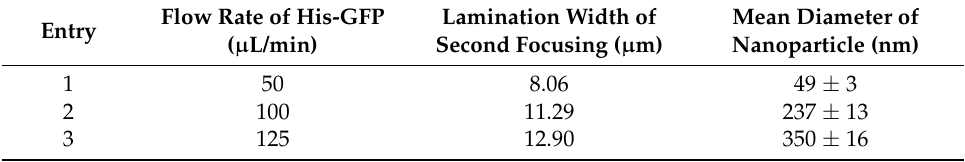
(c) Figure 7. Evaluation of the produced protein nanoparticles: ( a ) TEM image; ( b ) scanning electron microscope (SEM) image; ( c ) confocal fluorescence image. 5. Conclusions This paper examines the fast and controllable preparation of the protein nanoparticles in the flow-focusing synthesis channel. The Ni-NTA-PS and His-GFP was self-assembled on the interfacial surface of the multi-laminated flow. Especially, the problem of aggregation and clogging of the self-assembled protein nanoparticles on the inner surface of the channel was improved by adding the retarding inlet channel. The width of the solution introduced from the retarding inlet channel could be controlled simply by regulating the inlet flow rates of the central inlet channel and the retarding inlet channel, which indicates the possible control of the duration of the self-assembly. It is demonstrated that the microfluidic synthesis has the advantages of a uniform size control, a fast reaction, and a precise control of the reaction conditions for the preparation of protein nanoparticles by regulating inlet flow rates. For future study, the attachment of various antigenic molecules and the encapsulation of drugs inside the protein nanoparticles can be challenged. Acknowledgments: This work was supported by a 2-Year Research Grant of Pusan National University. Author Contributions: Hyeong Jin Jeon and Chae Yeon Lee equally designed experiment and synthesis of nanoparticles; Hyeong Jin Jeon and Moon Jeong Kim fabricated microfluidic devices; Chae Yeon Lee and